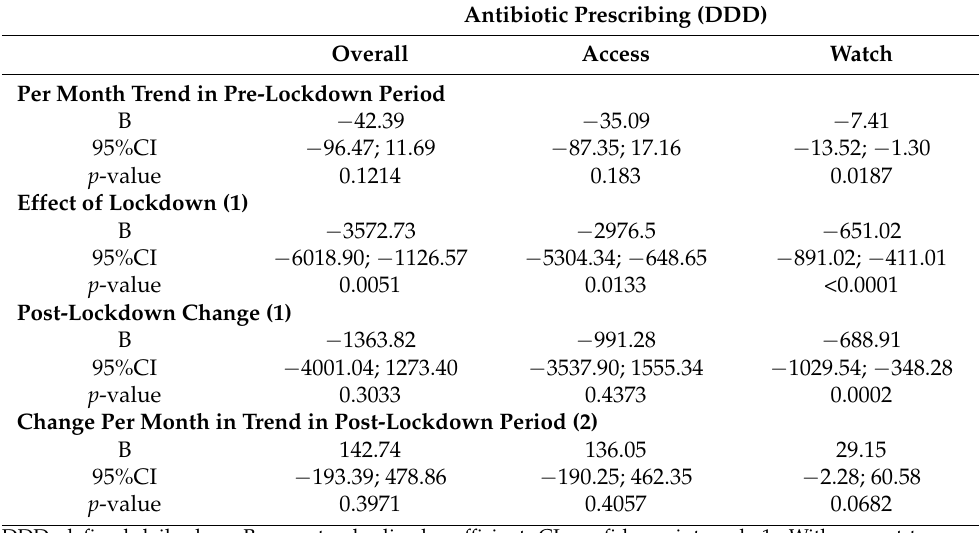
Figure 1. Monthly antibiotic prescribing trend in defined daily doses (DDD). Blue line ( − ): trend, after model adjustment; blue dashed line: expected trend with no COVID-19 outbreak; +: monthly antibiotic prescribing in DDD. Table 2. Segmented regression analysis of interrupted time series data on antibiotic prescribing.[14]